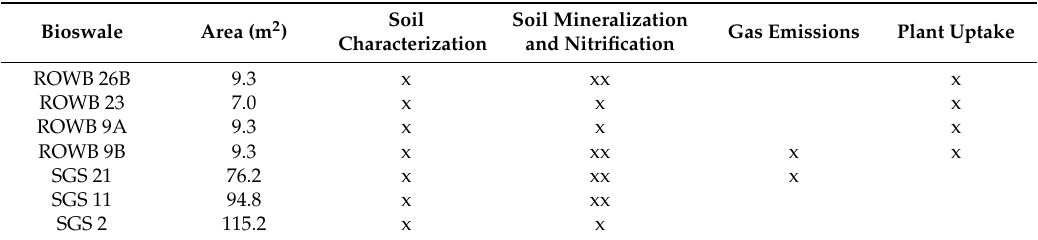
Table 1. Bioswale sampling summary. Sites that received more intensive sampling to evaluate within-site spatial variability in soil mineralization and nitrification are designated by “xx”. ROWB: right-of-way bioswale; SGS: stormwater greenstreet.